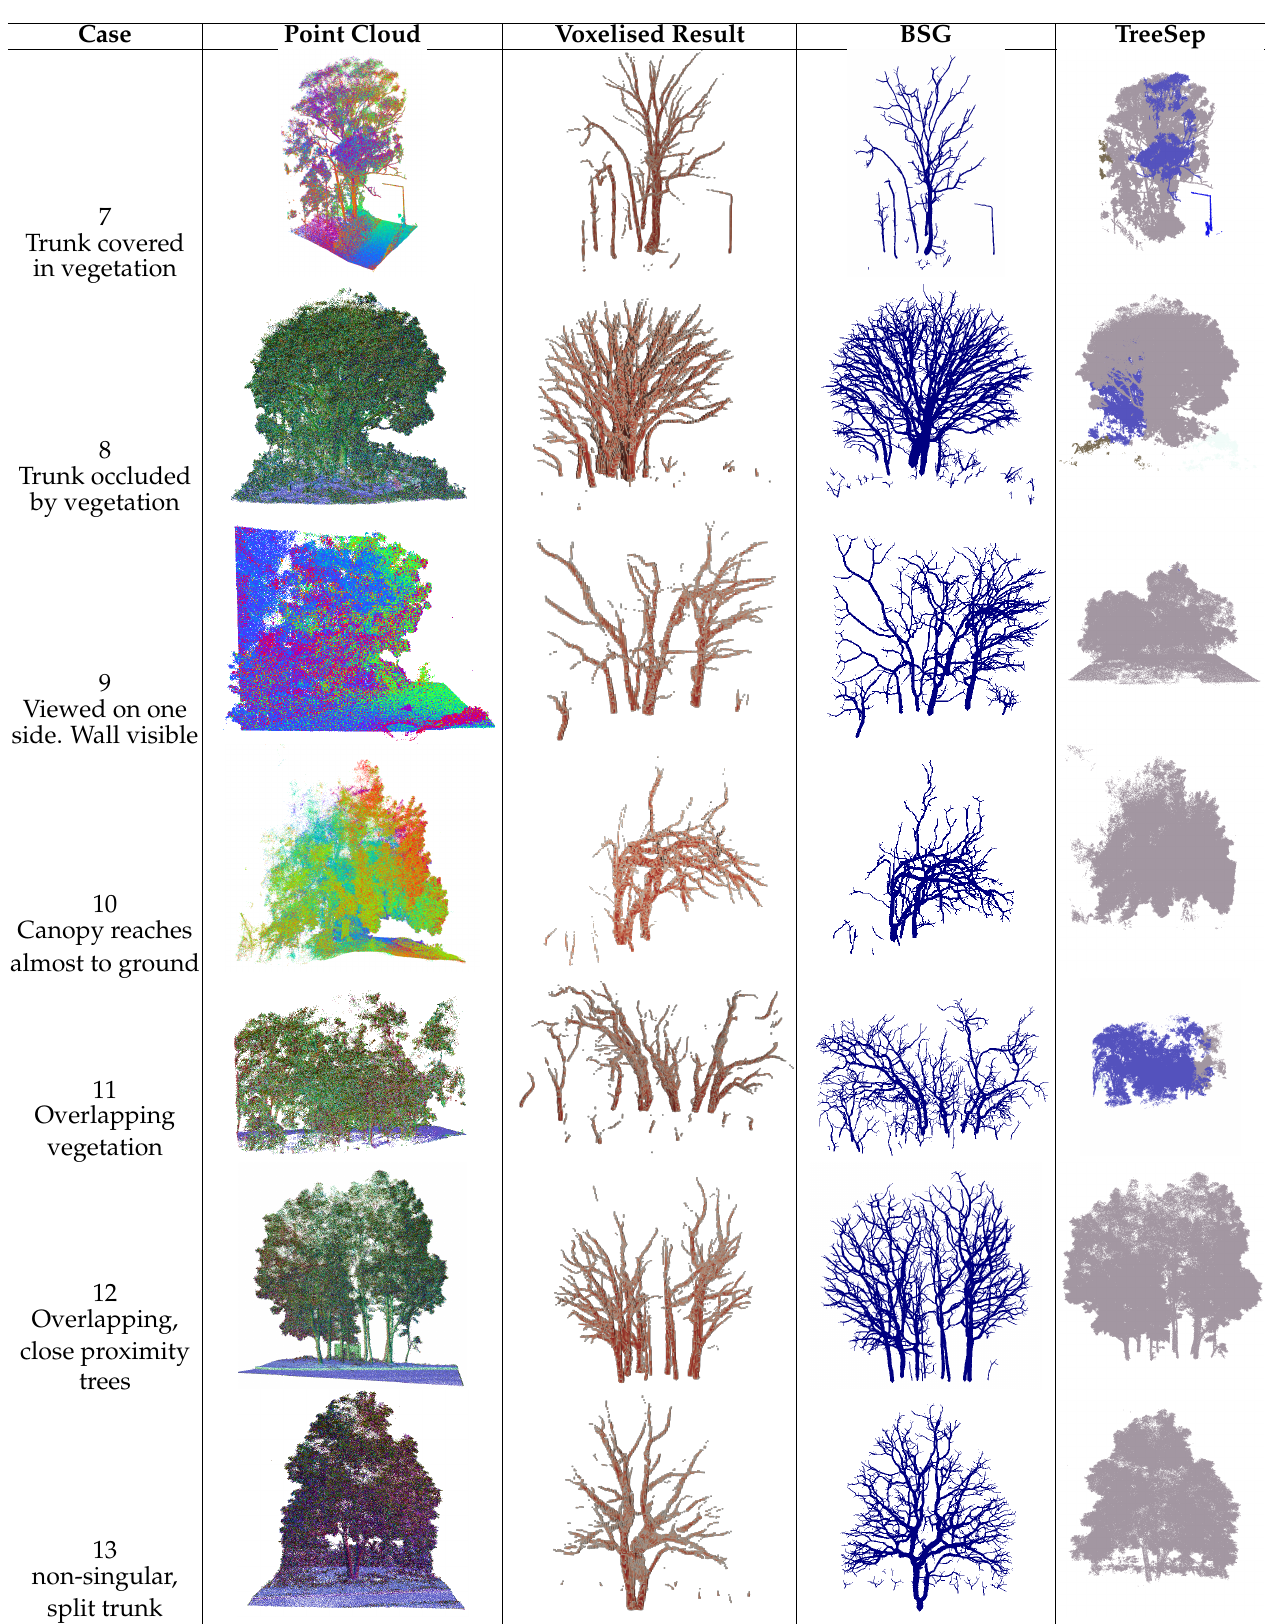
Table 2. Qualitative results (Part 2), showing the original point cloud, topology optimised voxel representation of the tree, and the reconstructed branch structure graph. The segmented trees produced by TreeSep [12] are presented for